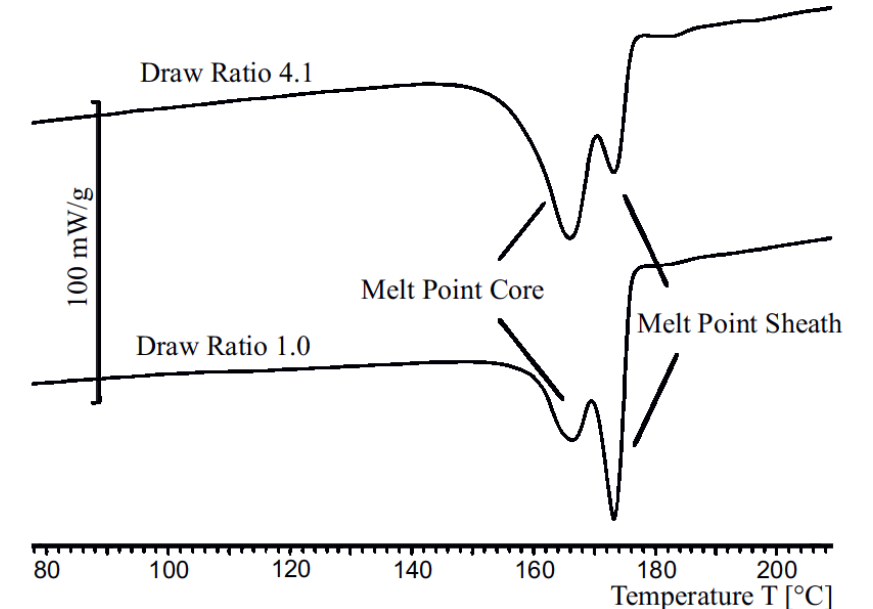
Figure 6. DSC results for undrawn and drawn fibers at draw ratios 1.0 and 4.1